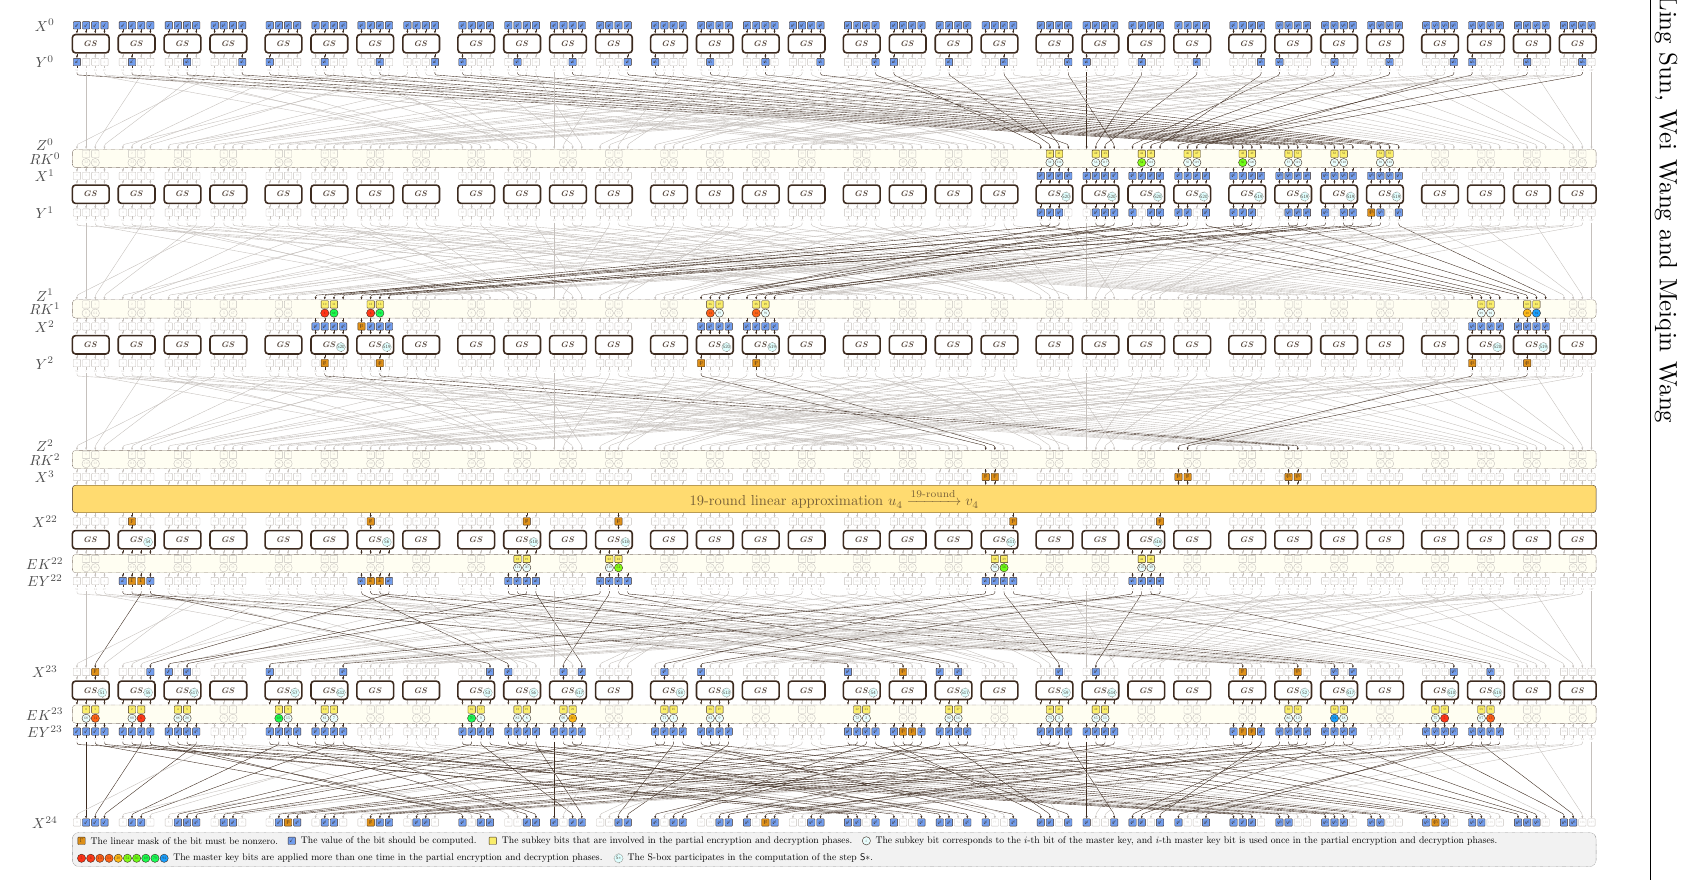
Thesubkeybitsthatareinvolvedinthepartialencryptionanddecryptionphases. i Thesubkeybitcorrespondstothe i -thbitofthemasterkey,and i -thmasterkeybitisusedonceinthepartialencryptionanddecryptionphases. 5 6 13 14 30 54 56 69 70 94 Themasterkeybitsareappliedmorethanonetimeinthepartialencryptionanddecryptionphases. S ∗ TheS-boxparticipatesinthecomputationofthestep S ∗ .